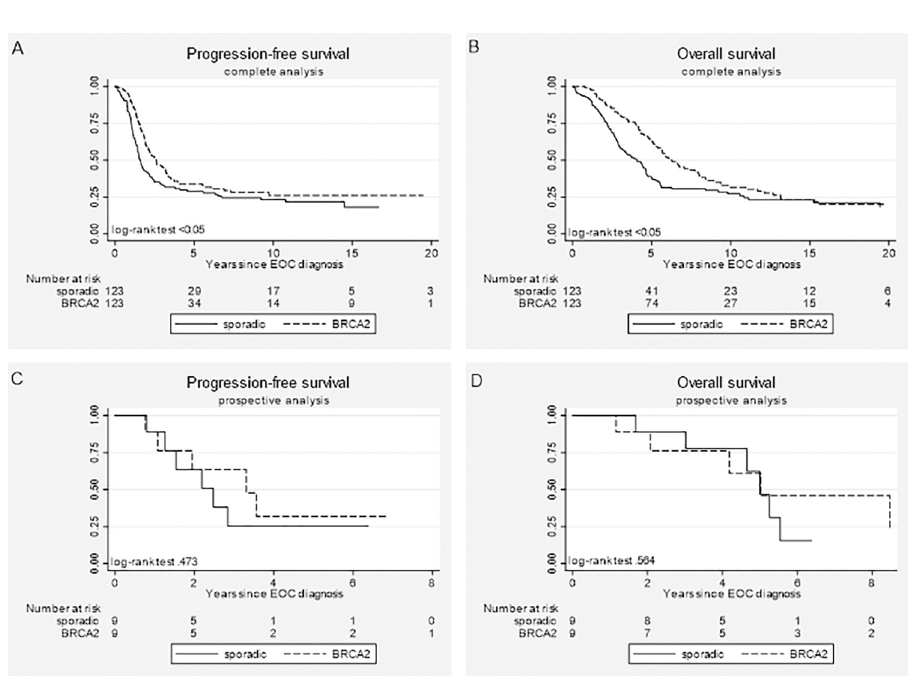
Fig 2. Kaplan-Meier survival curves for BRCA2- associated epithelial ovarian cancer (EOC) patients (dashed lines) and sporadic EOC patients (solid lines) treated with chemotherapy. (A) progression-free survival and (B) overall survival for the complete dataset; (C) progression-free survival and (D) overall survival for the prospective